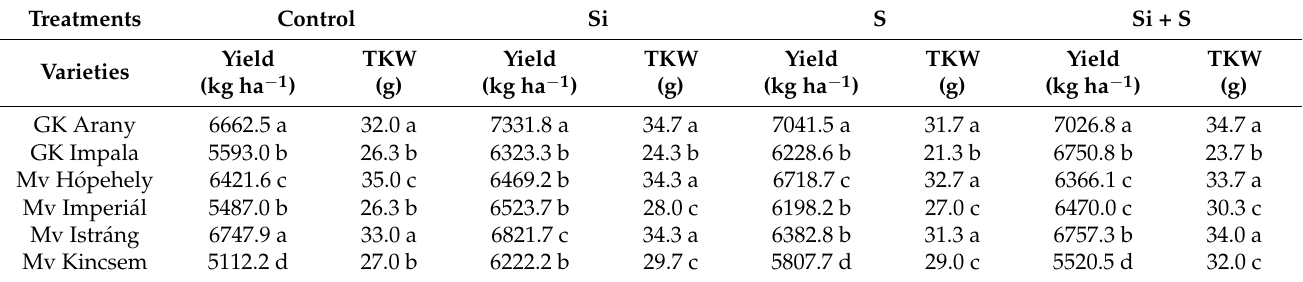
Table 4. Yield and thousand kernel weight of winter oat as an effect of the treatments (Debrecen, 2021). Treatments Control